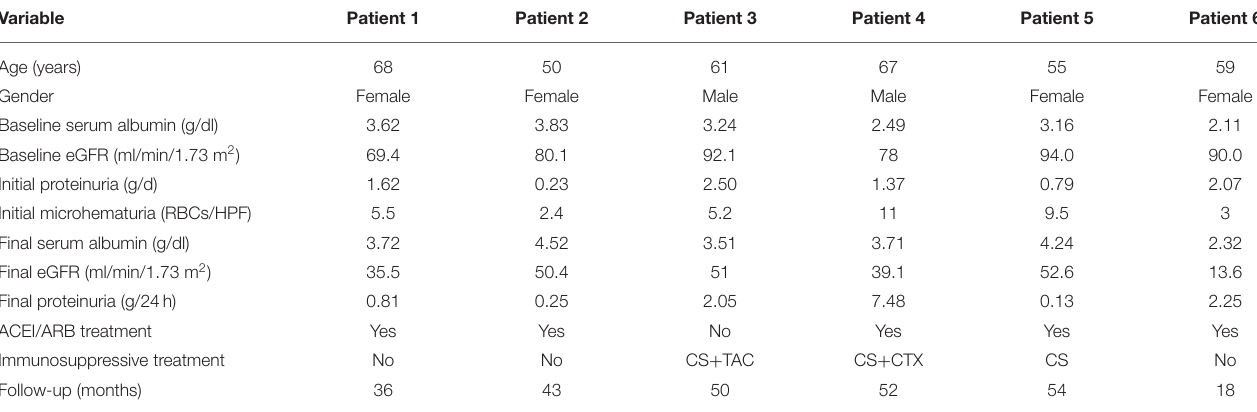
TABLE 6 | Clinical characteristics of patients with 40% loss in the kidney function.